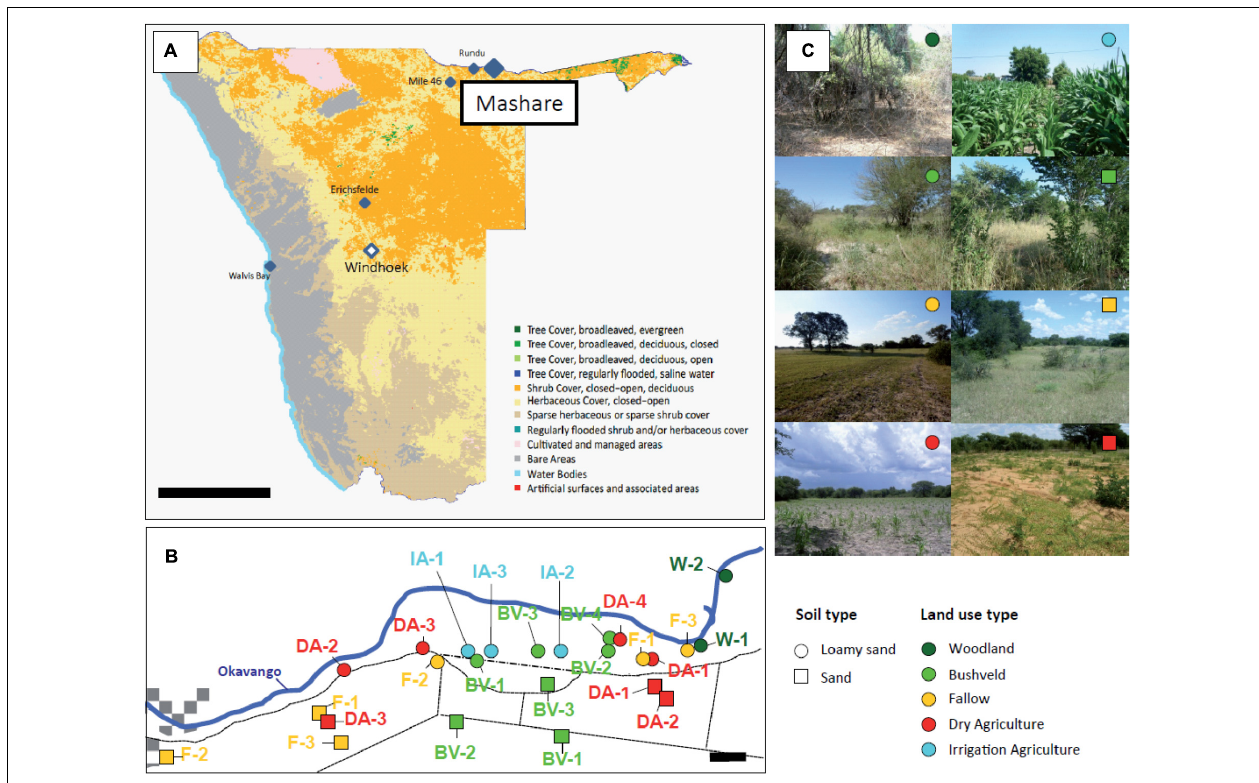
FIGURE 1 | (A) Overview map of Namibia with the highlighted sampling areas in Mashare, Rundu (N’Kwazi Lodge) and Erichsfelde. Bar, 300 km. (B) Detailed map of the sampling locations in the Mashare region. Bar, 1 km. (C) Representative photographs of the eight different types of sampling locations present in Mashare. In (B,C) soil types (loamy sand, circles; and sand, squares) and land use types (woodland, dark green; bushveld, green; fallow, yellow; dry agricultue, red; irrigation agriculture, blue) are denoted by different